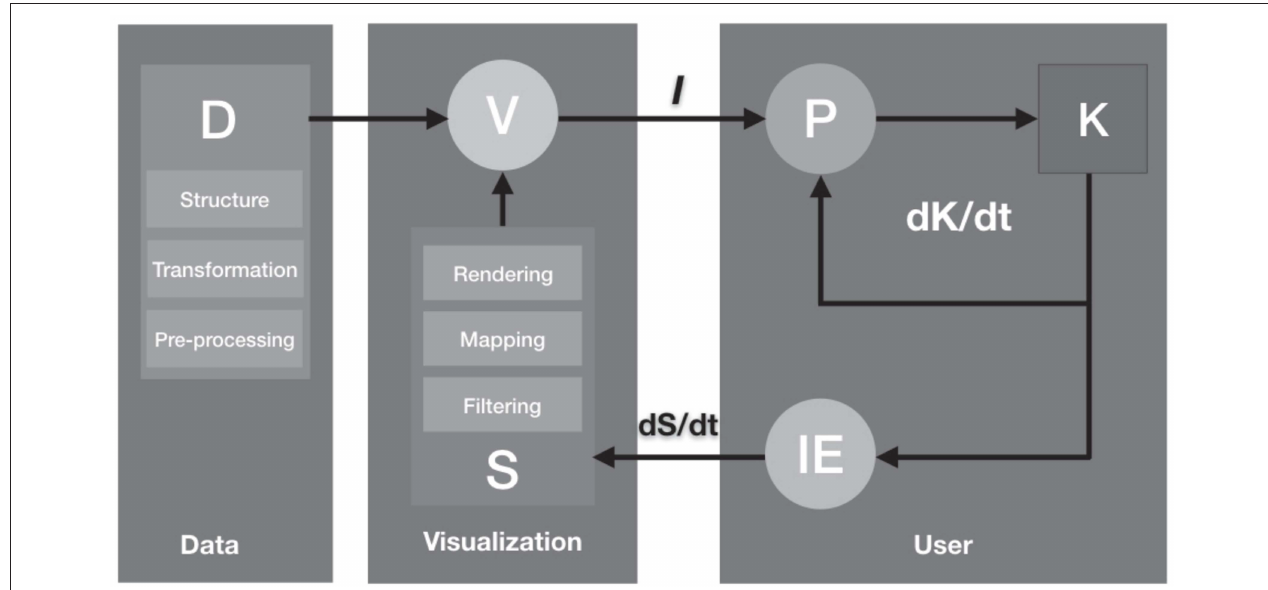
FIGURE 1 | Model of Visualization (after Van Wijk, 2005 and Liu et al., 2014). This figure shows a schematic model of the visualization process, incorporating human-computer interaction. Moreland, 2016; Ware et al., 2018). Most importantly for data visualization, there is no meaningful metric for representing color difference in RGB, HSL, or HSV color spaces that match human perception of color differences (Robertson,